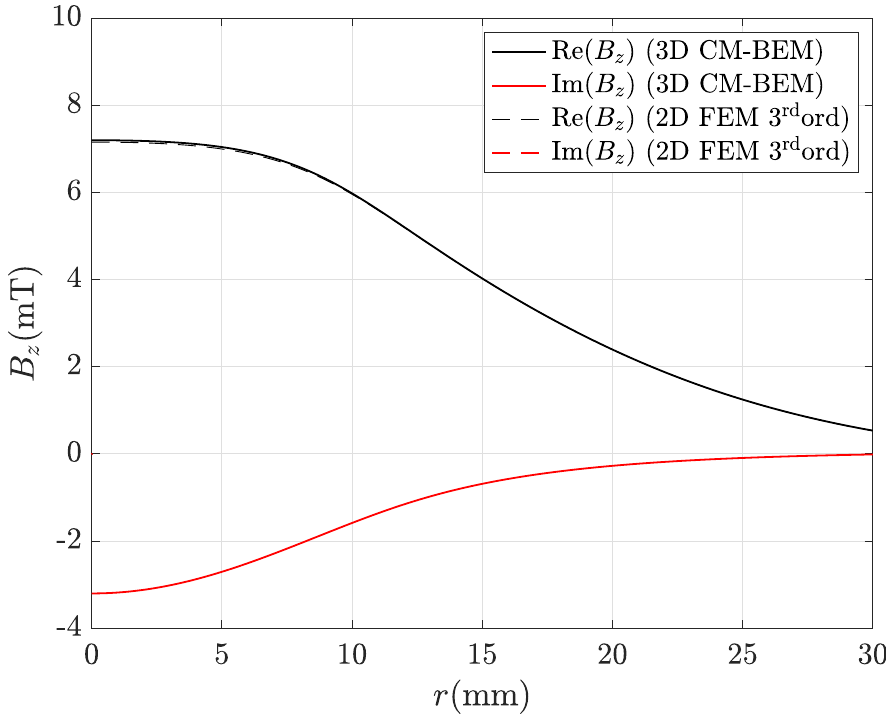
Figure 5. Real and imaginary parts of the magnetic flux density radial component B z along line A–B depicted in Figure 1 computed by the hybrid method with R-SVD matrix compression: CM-BEM is the straight line, third ord. 2D FEM (reference) is the dashed